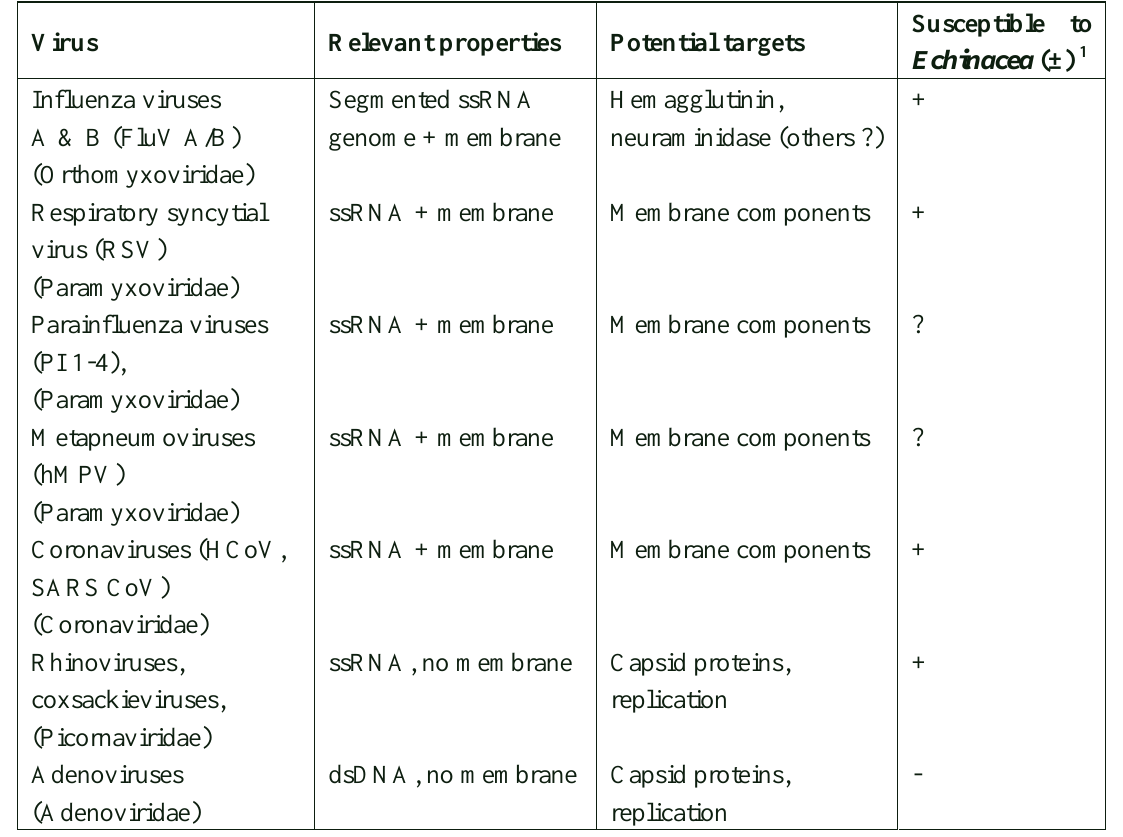
Table 1 . Respiratory viruses and their potential